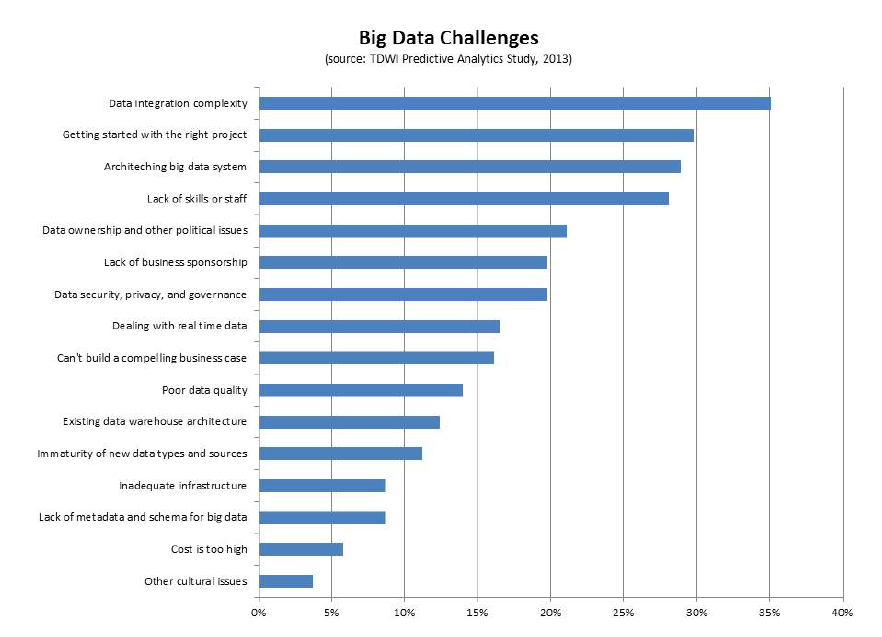
Figure 2. Big data Challenges (Source: TDWI predictive analytics study,